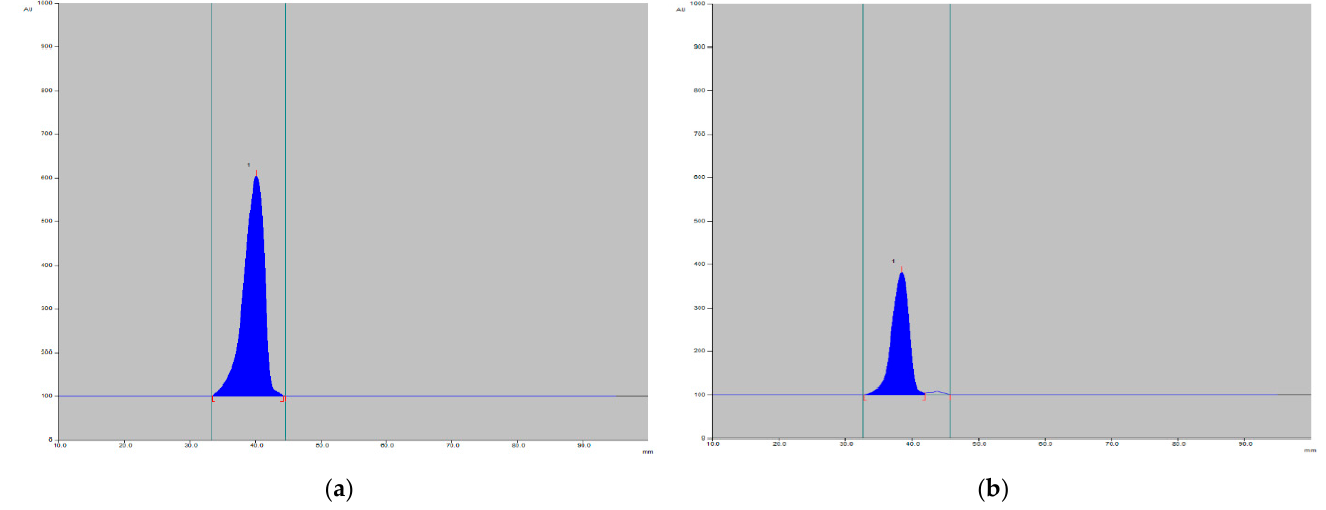
Figure 2. An example of a densitogram for ‘CEF, GES + ETYN’ registered at 80 °C, after ( a ) 0 h, ( b ) 0.5 h.